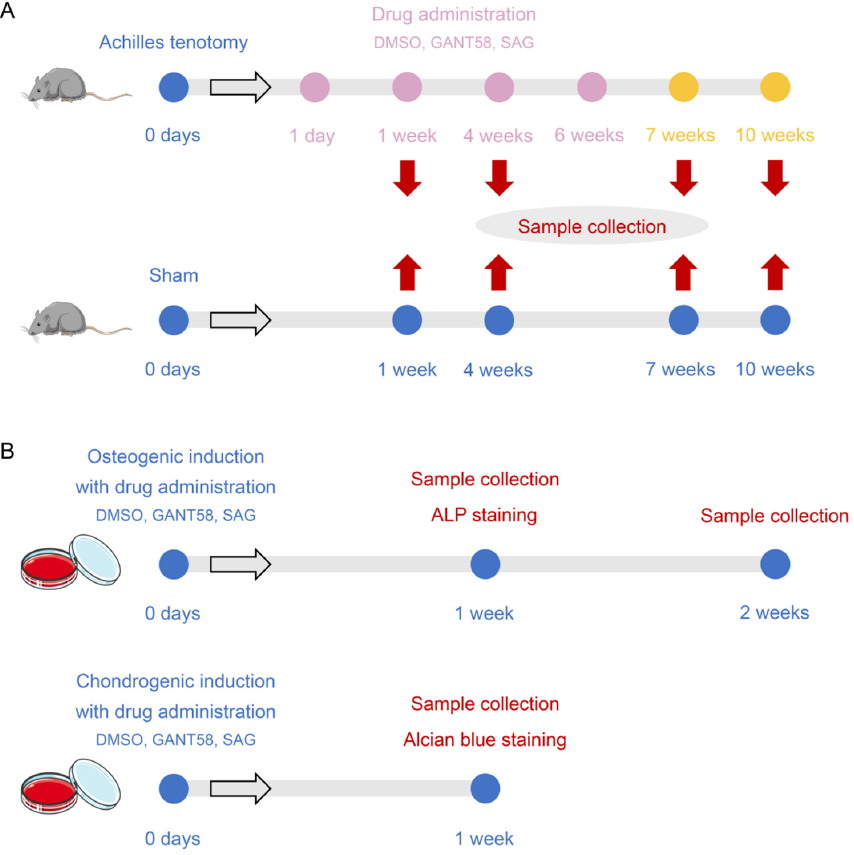
Figure 1. Schematic diagram of experiment design. ( A ) Animal experiment design. ( B ) Cell experi ‐ ment design.